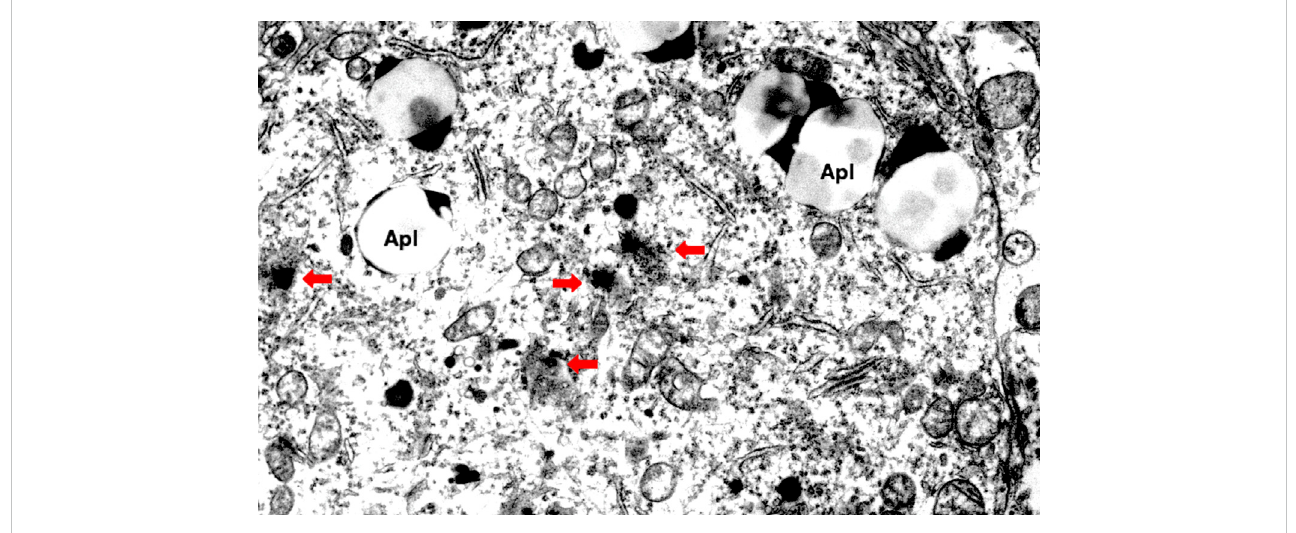
Electron microphotograph of the lysosomal rupture being observed in the cortical neuron of human Alzheimer patient. Red arrows are lysosomal membrane rupture/permeabilization, which shows a remarkable contrast to the intact lysosome (circles). Apl: autophagolysosome (Reprinted from Yamashima